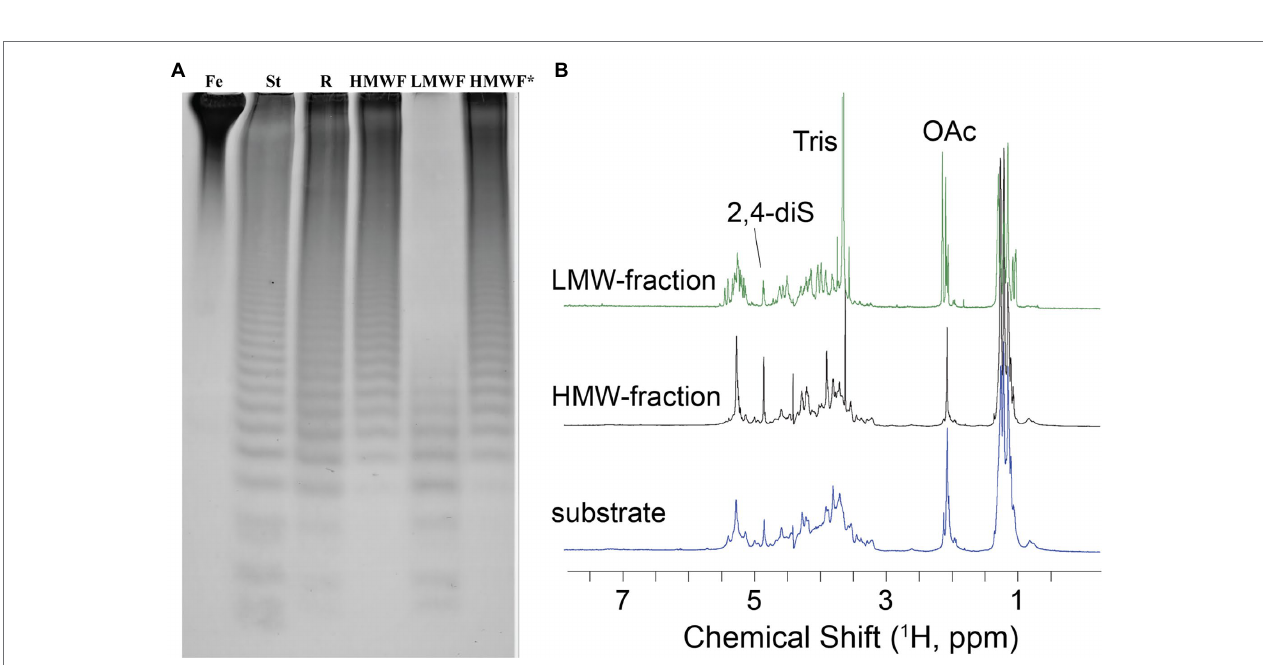
FIGURE 8 | Characterization of the Fhf2 ∆ 484 hydrolysis products. (A) Enzymatic reaction of Fhf2 Δ 484 on fucoidan from F. evanescens shown by C-PAGE. (FeF2) control fucoidan substrate from F. evanescens . (R) Enzymatic reaction of Fhf2 Δ 484 on fucoidan from F. evanescens , (HMWF) high molecular weight fucoidan and (LMWF) low molecular weight fucoidan, (HMWF*) second enzyme treatment of HMWF with Fhf2 Δ 484. (St) positive control reaction of FFA2 on F. evanescens fucoidan. (B) 1 H NMR spectra of F. evanescens fucoidan substrate (blue), high molecular weight fraction (black) and low molecular weight fraction (green) after hydrolysis by Fhf2 Δ 484.